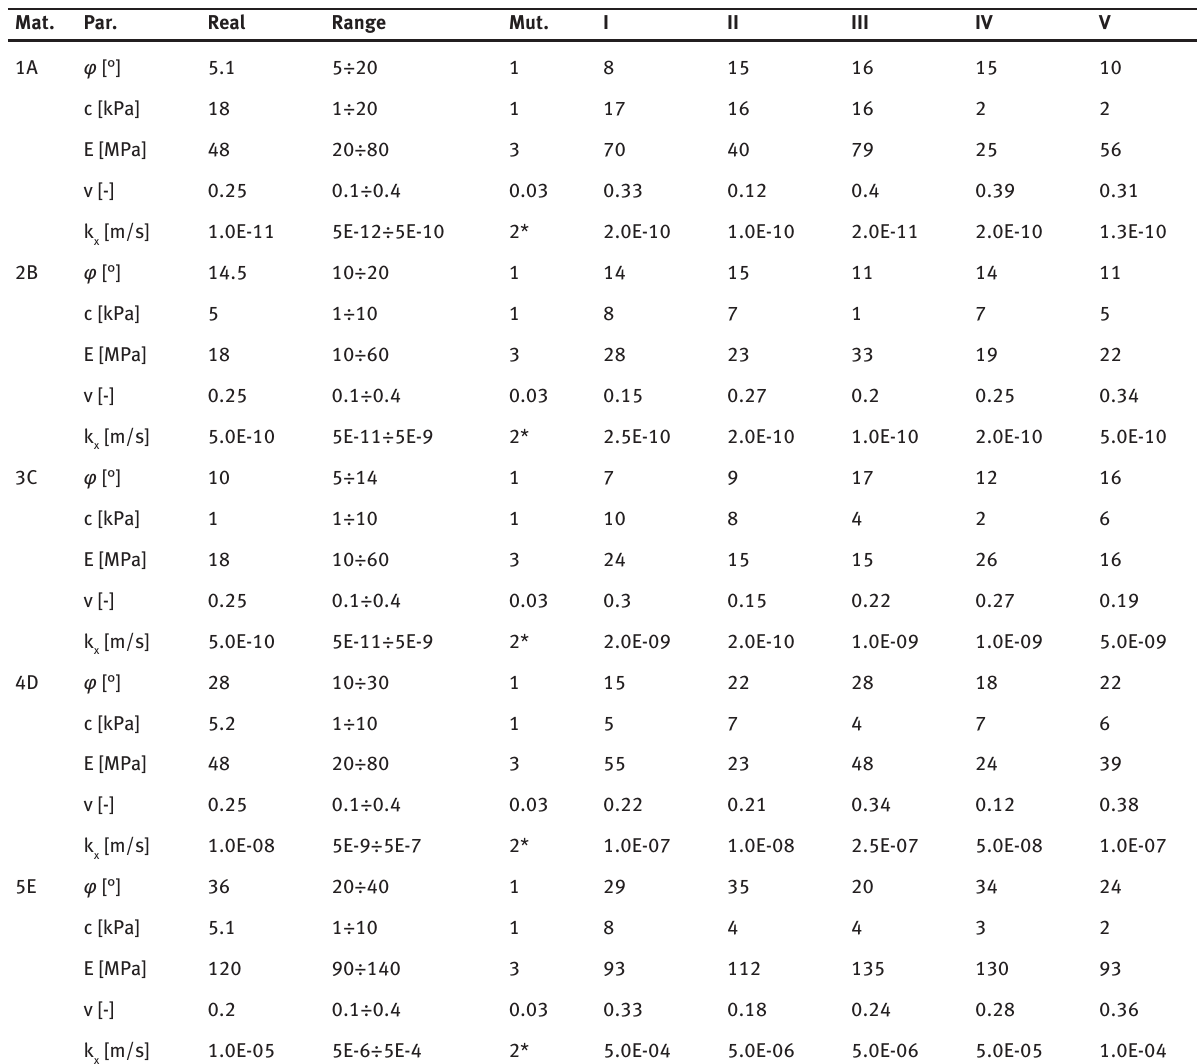
Table 1: Parameters resulting from calibration. Mat.